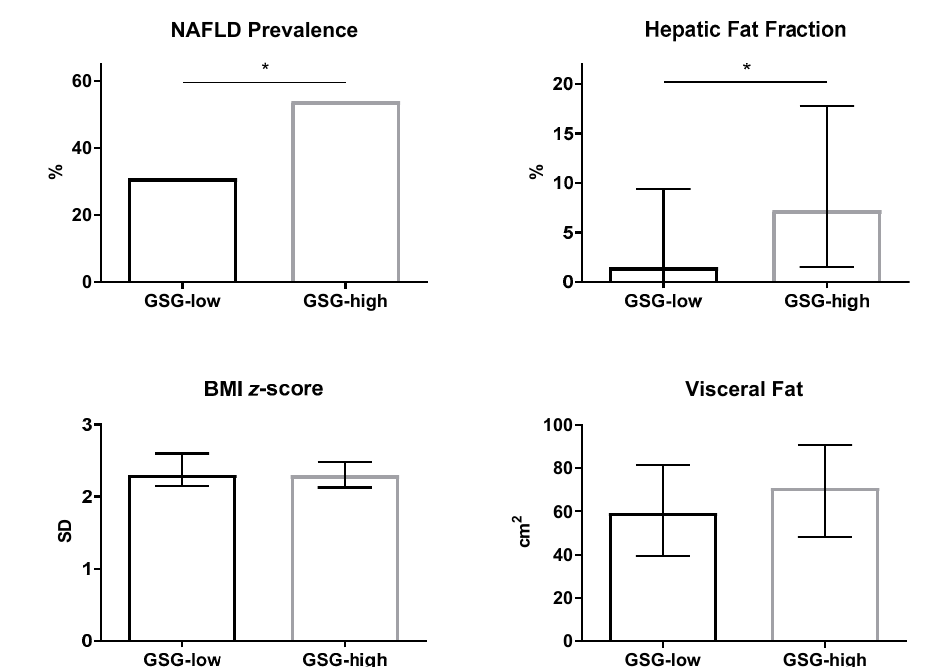
Figure 1. Prevalence of non-alcoholic fatty liver disease (NAFLD), hepatic fat fraction, BMI z-score, and visceral fat in obese adolescents with GSG-low and GSG-high. NAFLD prevalence is reported as percentage. Other data are reported as median and interquartile range. * p <